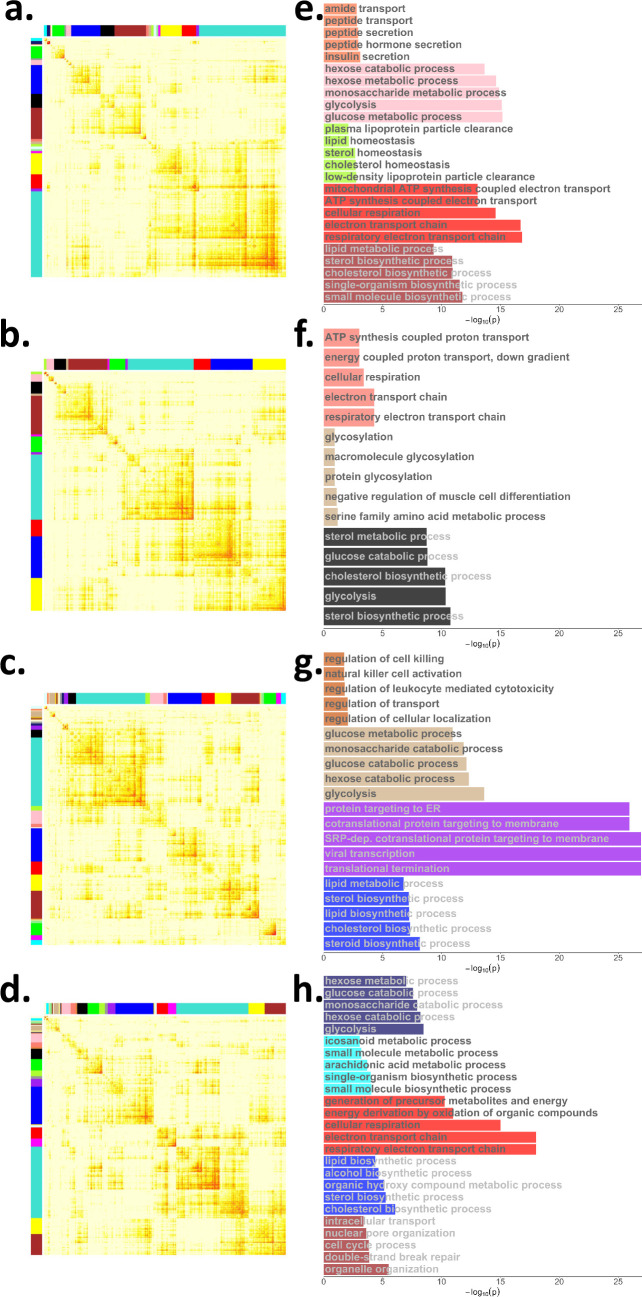
The topological overlap matrix (TOM) indicating co-expression between genes and their corresponding pathway enrichment analysis of the IR and IS co-expression network in AS and ApP.The color bars on top and to the left of each TOM indicate different co-expression modules (WGCNA labels co-expression modules according to a sequence of colours; each colour corresponds to a different module with no further meaning of the colour labels). Only genes included in co-expression modules are shown. The color scales for the different TOMs depend on the soft power parameter used by WGCNA and hence we have not provided color scales for these heatmaps; the main point of the TOM is to show the connections (i.e. co-expression) between blocks (i.e. modules) of genes. Each module of co-expressed genes will correspond to different biological functions and thus an annotation of the modules will allow us to select modules to seed the predictive networks. (a) TOM of IR in AS; (b) TOM of IS in AS; (c) TOM of IR in ApP; (d) TOM of IS in ApP. (e)-(h) Pathway enrichment analysis results for selected modules from each co-expression networks in (a)-(d).